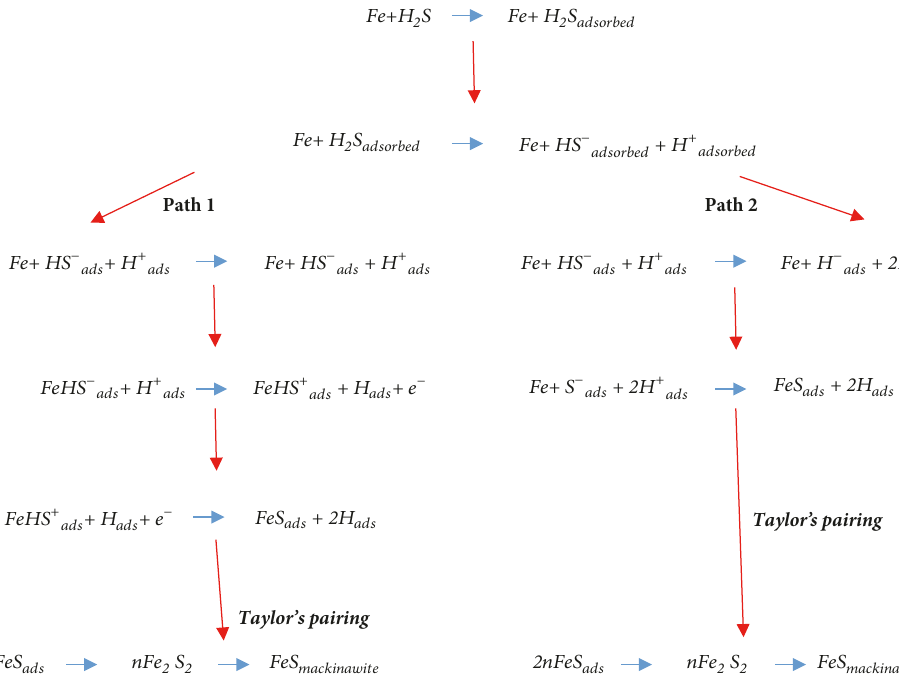
Figure 2: Mechanisms proposed for H 2 S aqueous corrosion of mild